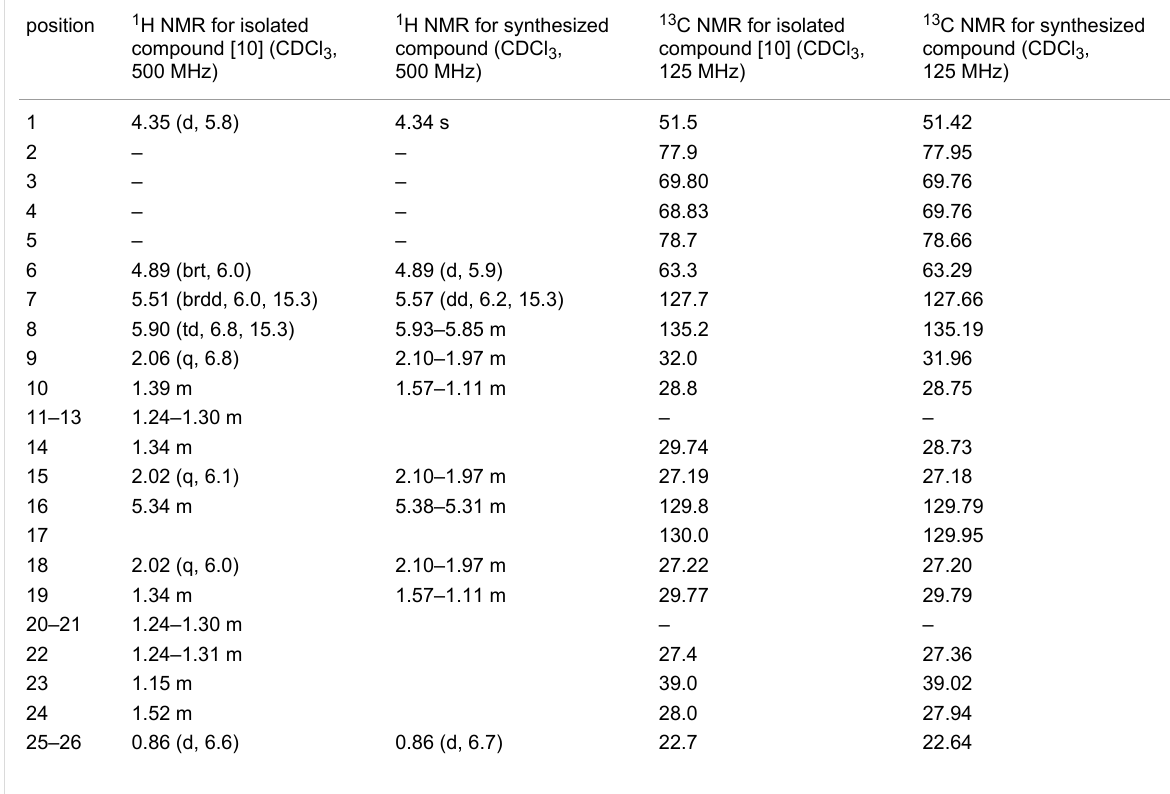
Table 2: Comparison of 1 H and 13 C NMR data of strongylodiol I (isolated natural product vs synthetic).